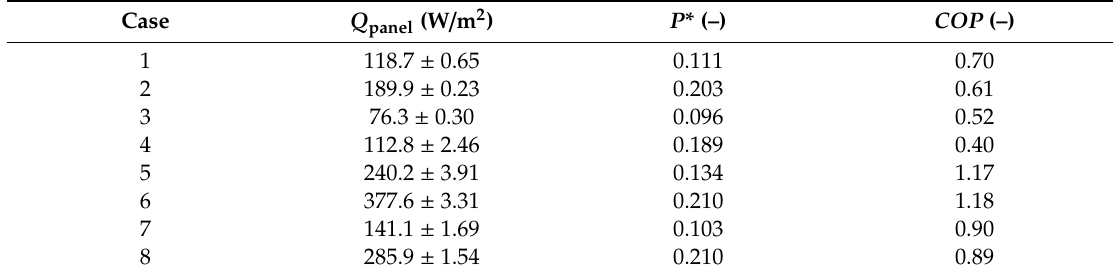
Table 5. Experiment results for developing the empirical model of the TERP in the heating